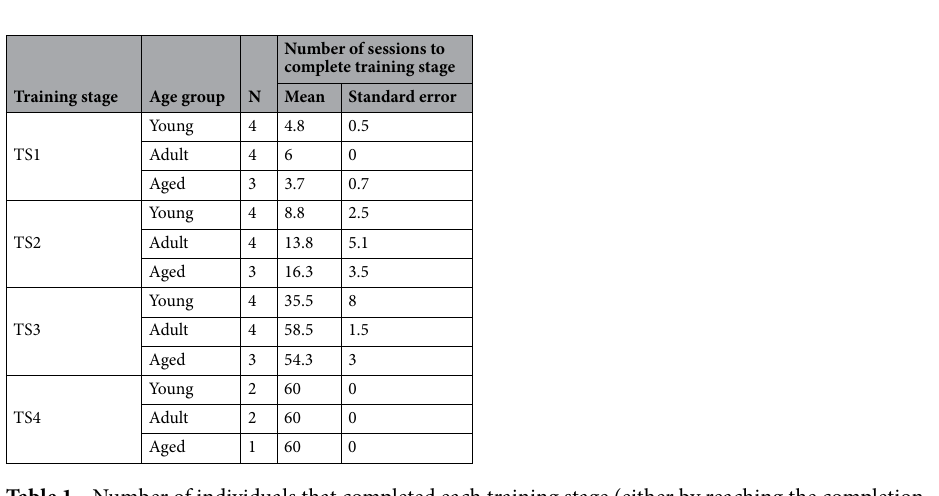
Figure 3. Number of sessions required to reach completion criterion in each training stage (TS) for each individual per age group. Denominations in the figure legends refer to individual pigeons.